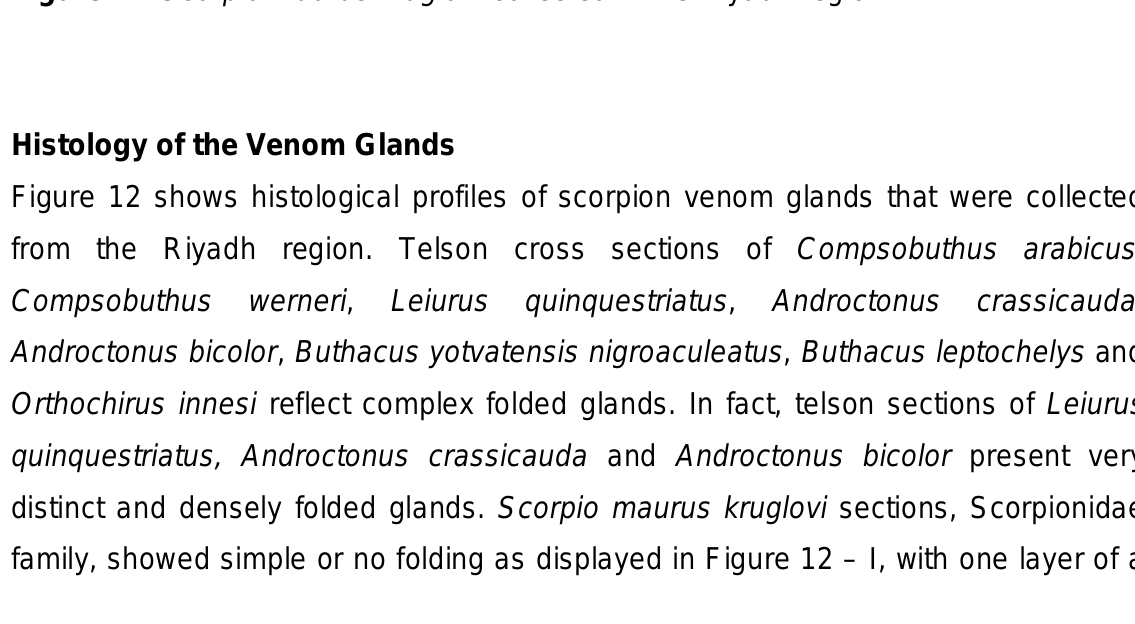
Figure 11. Scorpio maurus kruglovi collected in the Riyadh region